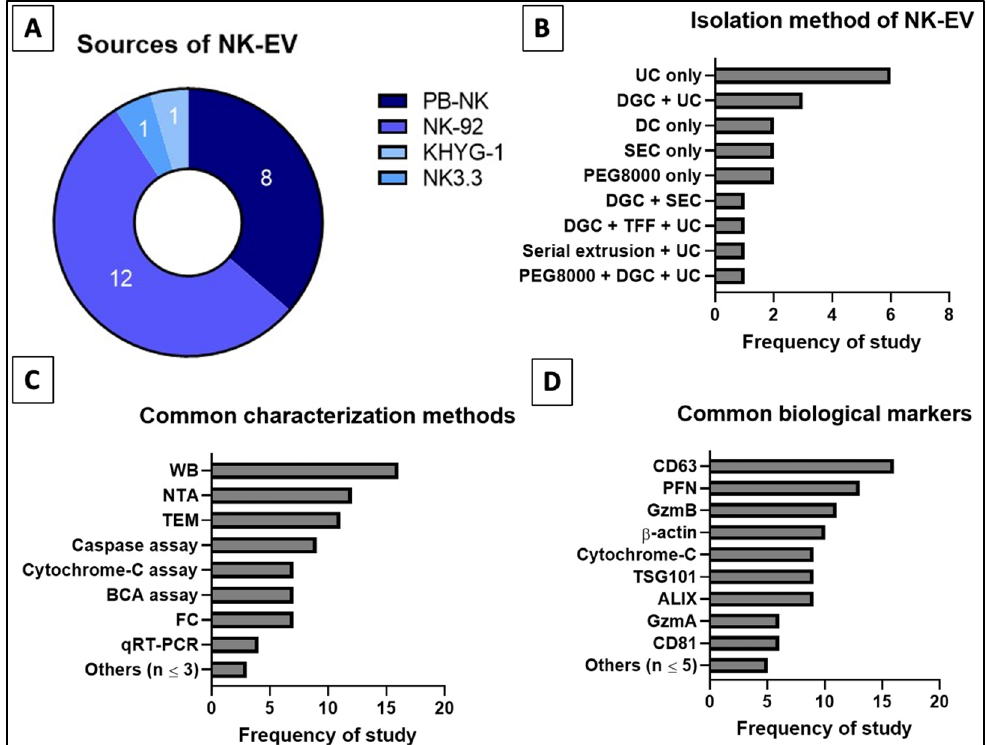
Figure 7. Distribution of reviewed studies for ( A ) source, ( B ) isolation techniques (single or combined), ( C ) common characterization assays and ( D ) common biological markers for NK-EVs. Numbers indicated in ( A ) refer to the frequency of reviewed studies that fall into the categories.